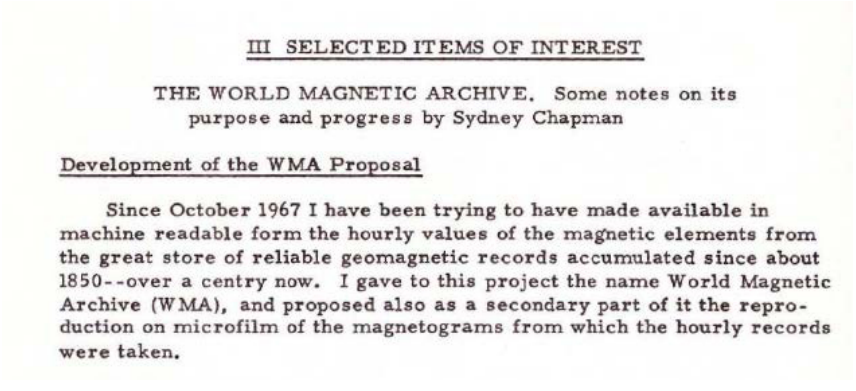
Figure 4. Extract from the IAGA News 1969 devoted to archiving the geomagnetic observations and dissemination of the geomagnetic